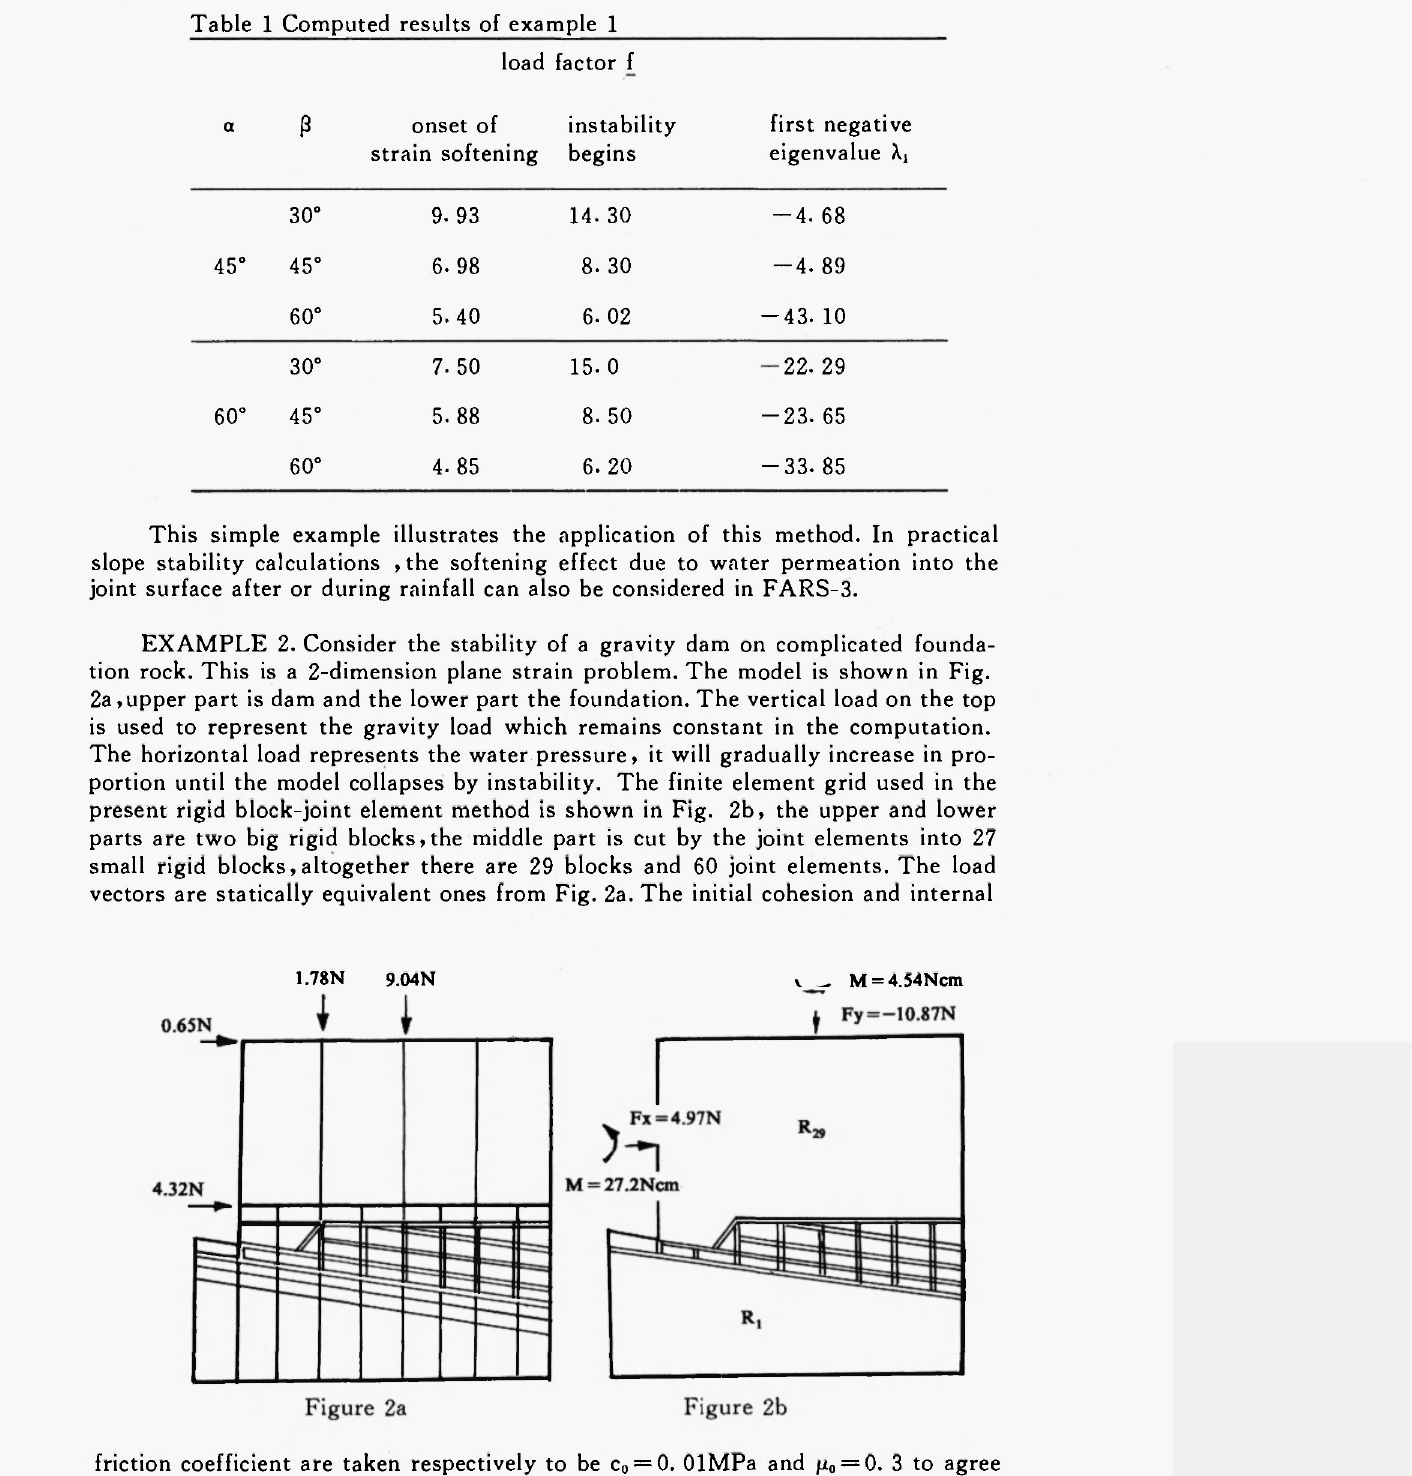
Table 1 Computed results of example